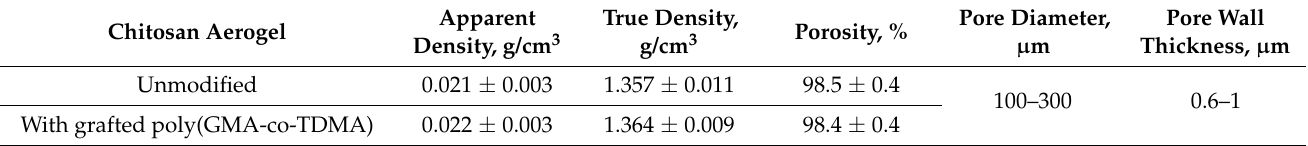
Table 5. Physical characteristics of chitosan aerogels.